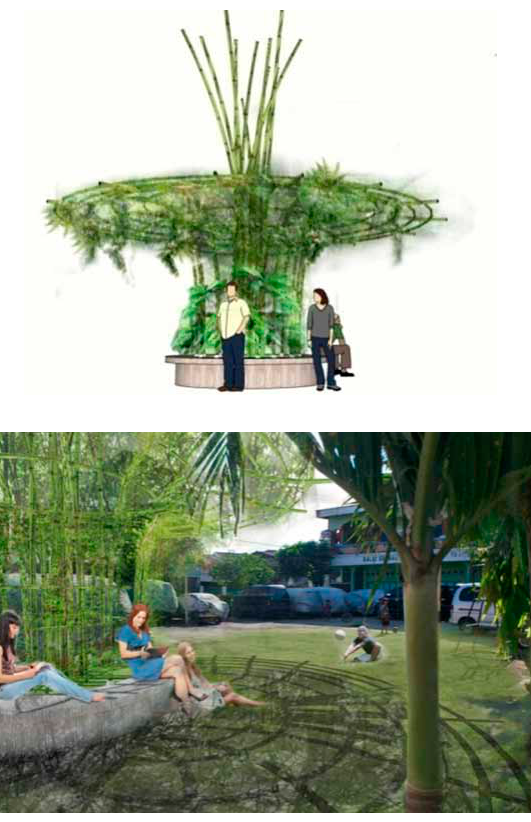
fig. 13. rendered image of suggested design on the field (created by the